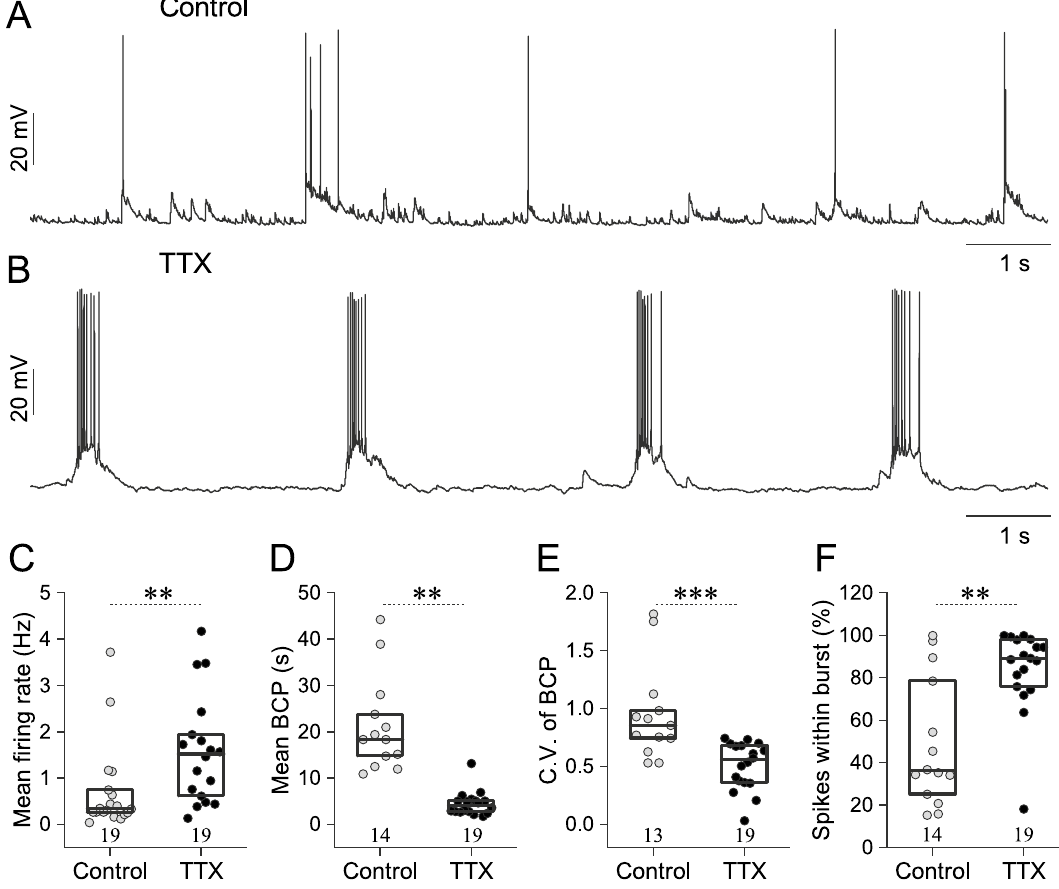
Figure 1. Activity-deprivation by 48 h TTX treatment increases the spontaneous firing rate of cultured hippocampal neurons while regularizing their bursting. Spontaneous membrane potential fluctuations and firing of hippocampal neurons are shown in ( A ) (control) and ( B ) (after 48 h of TTX-treatment). ( C ) Mean firing rate of neurons calculated as the total number of emitted spikes divided by the duration of observation. ( D ) Significant decrease of mean burst cycle period (BCP) is observed in TTX-treated cells relative to the control ones. ( E ) The coefficient of variation (C.V.) of burst cycle periods is also decreased in the TTX group indicating more rhythmic occurrence of bursts. ( F ) The percentage of spikes observed in bursts. Box plots indicate medians and 25–75% range of data. Data are representative of seven (control) and four (TTX) independent cultures. The number of cells analyzed is indicated in the scatter plots (**p < 0.01; ***p < 0.001; Mann–Whitney U